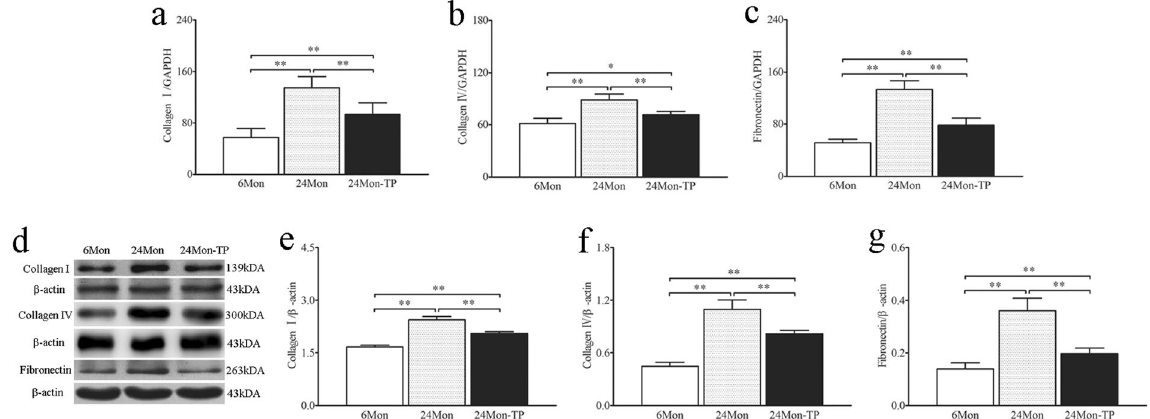
Figure 3. The effects of TP on the Collagen I, Collagen IV and fibronectin in the renal tissue of aged rats. Bar graphs show Collagen I mRNA ( a ), Collagen IV mRNA ( b ) and fibronectin mRNA ( c ). ( d ) Western blot study revealed Collagen I, Collagen IV and fibronectin expression in the renal tissue. Bar graphs illustrate the protein expression of Collagen I ( e ) Collagen IV ( f ) and fibronectin ( g ). The asterisks show significant differences ( * P < 0.05, ** P < 0.01).